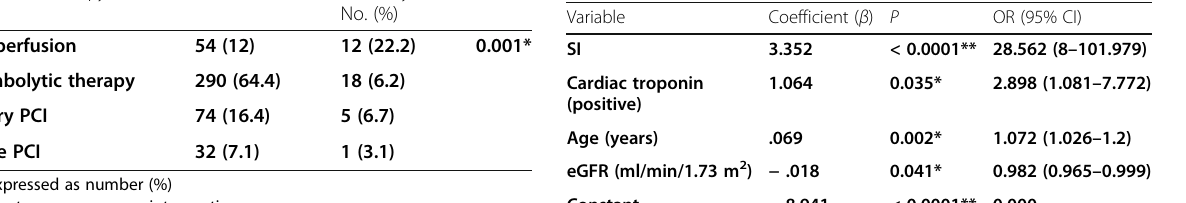
Table 4 Effect of type of reperfusion therapy on mortality Reperfusion therapy